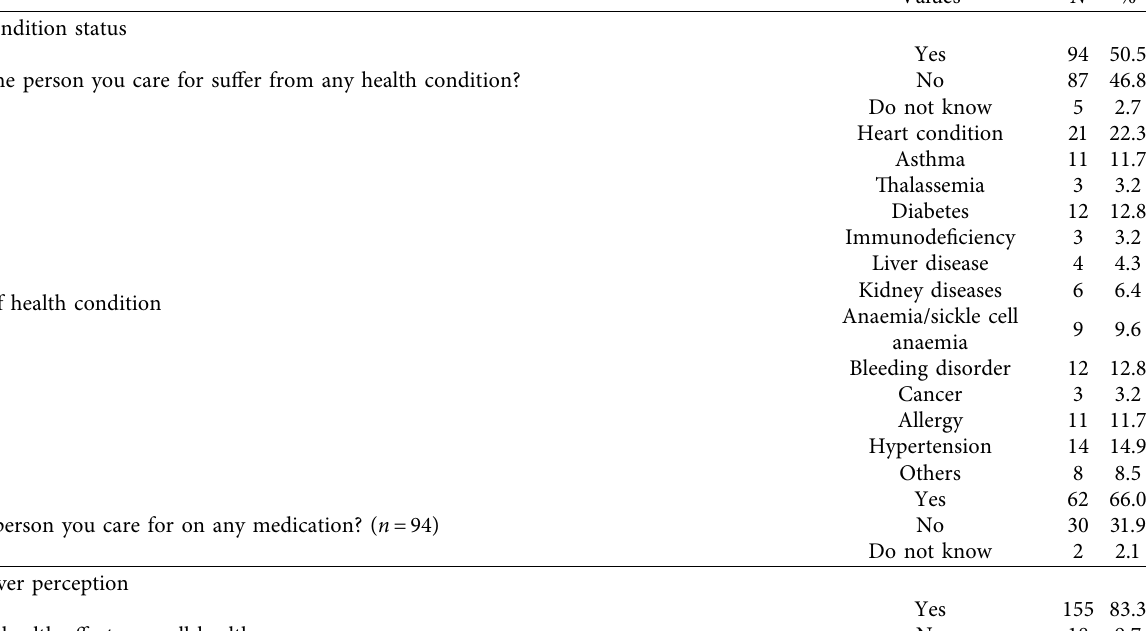
Table 2: Perception of caregivers about the relationship between oral health and overall health. Variables